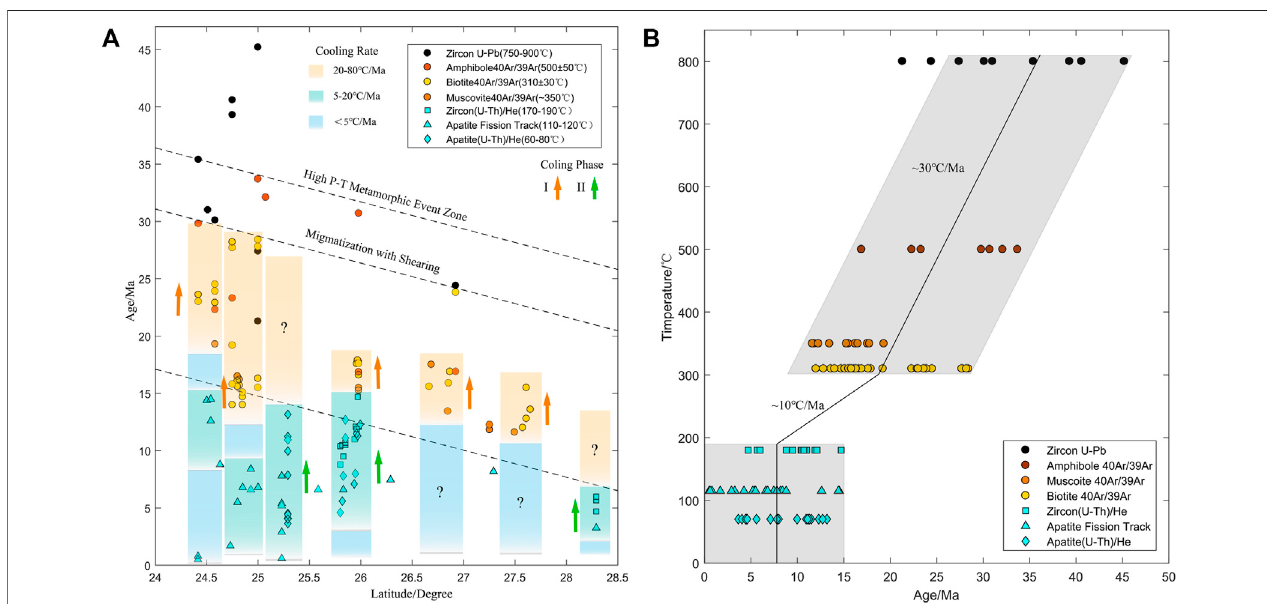
FIGURE 9 | Summary of thermochronological data for the Gaoligong shear zone (GLGSZ). Ages are compiled from Wang et al. (2008, 2018), Akciz et al. (2008), Gilley et al. (2003), Lin et al. (2009), Zhang et al. (2012, 2017), Xu et al. (2015), Ji et al. (2000), Ding (1991), Tang et al. (2016, 2020), and this study. A synthesis of these data suggests differentialthermalhistoriesalongthelatitude. (A) The GLGSZ experienced prominent and rapidcooling from ahigh temperature of > 500 – 190 ° Cat arate of 20 – 80 ° C/Ma during 30 – 15 Ma at 25 ° north latitude. A lower-magnitude accelerated cooling event took place during 15 – 0 Ma at 24.5 ° – 26 ° north latitude. (B) Age-temperature relationship of different thermochronological data of the